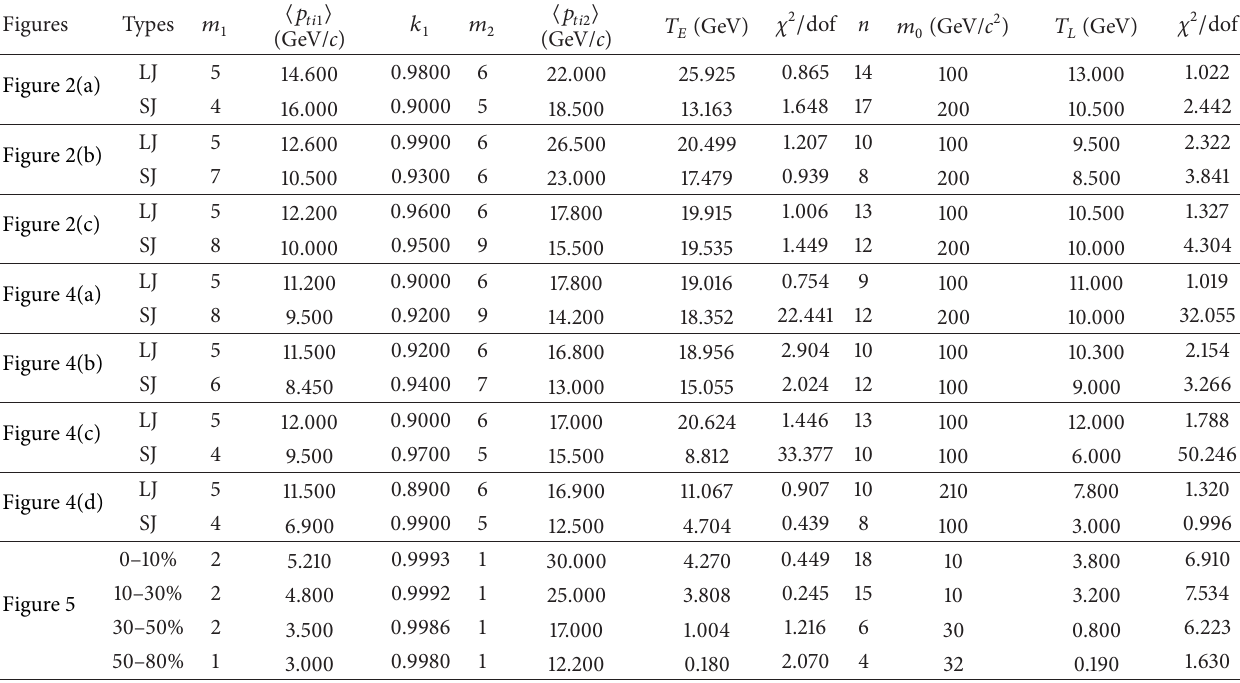
Table 2: Parameter values for the two kinds of curves in Figures 2, 4, and 5. The values of 𝜒 2 / dof and extracted temperatures are given. The abbreviations LJ and SJ represent leading and subleading jets, respectively. The errors for 𝑚 1 , 𝑚 2 , and 𝑛 can be neglected, and the relative errors for other parameters are less than 10%.